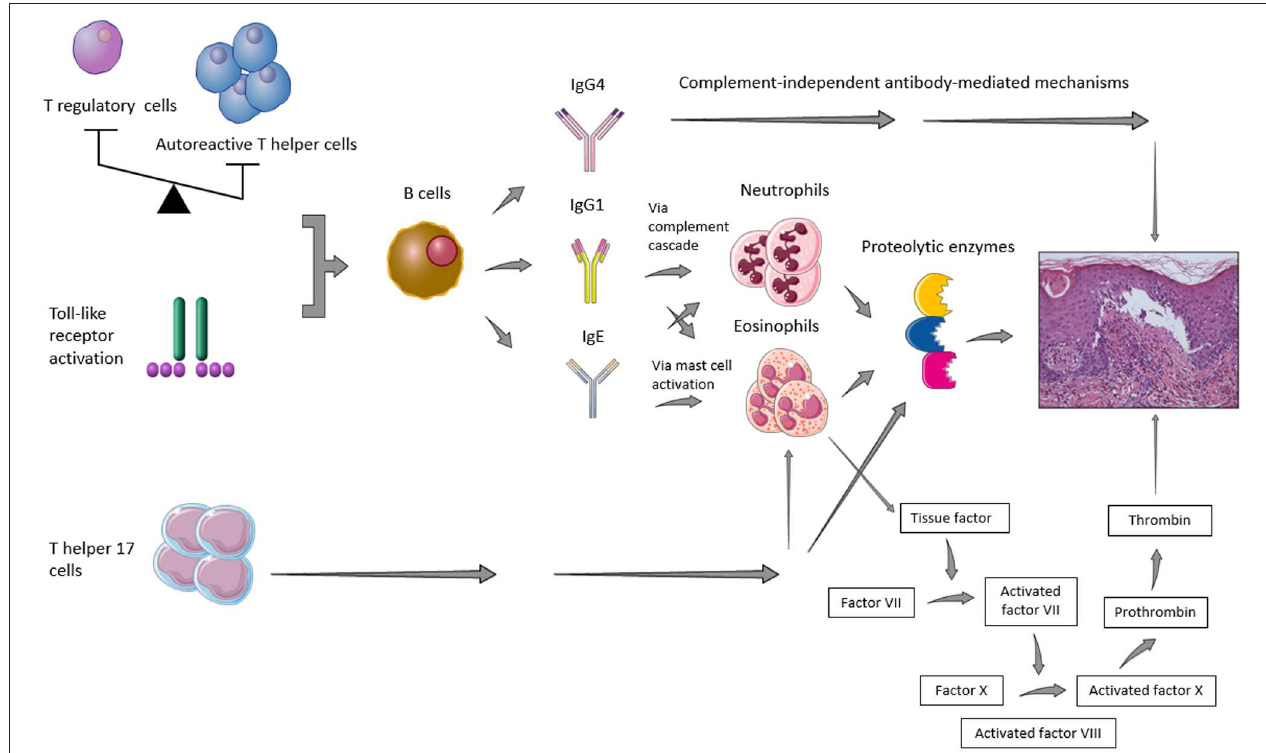
FIGURE 1 | Representative figure of the main pathogenic pathways implied in blister formation in patients with bullous